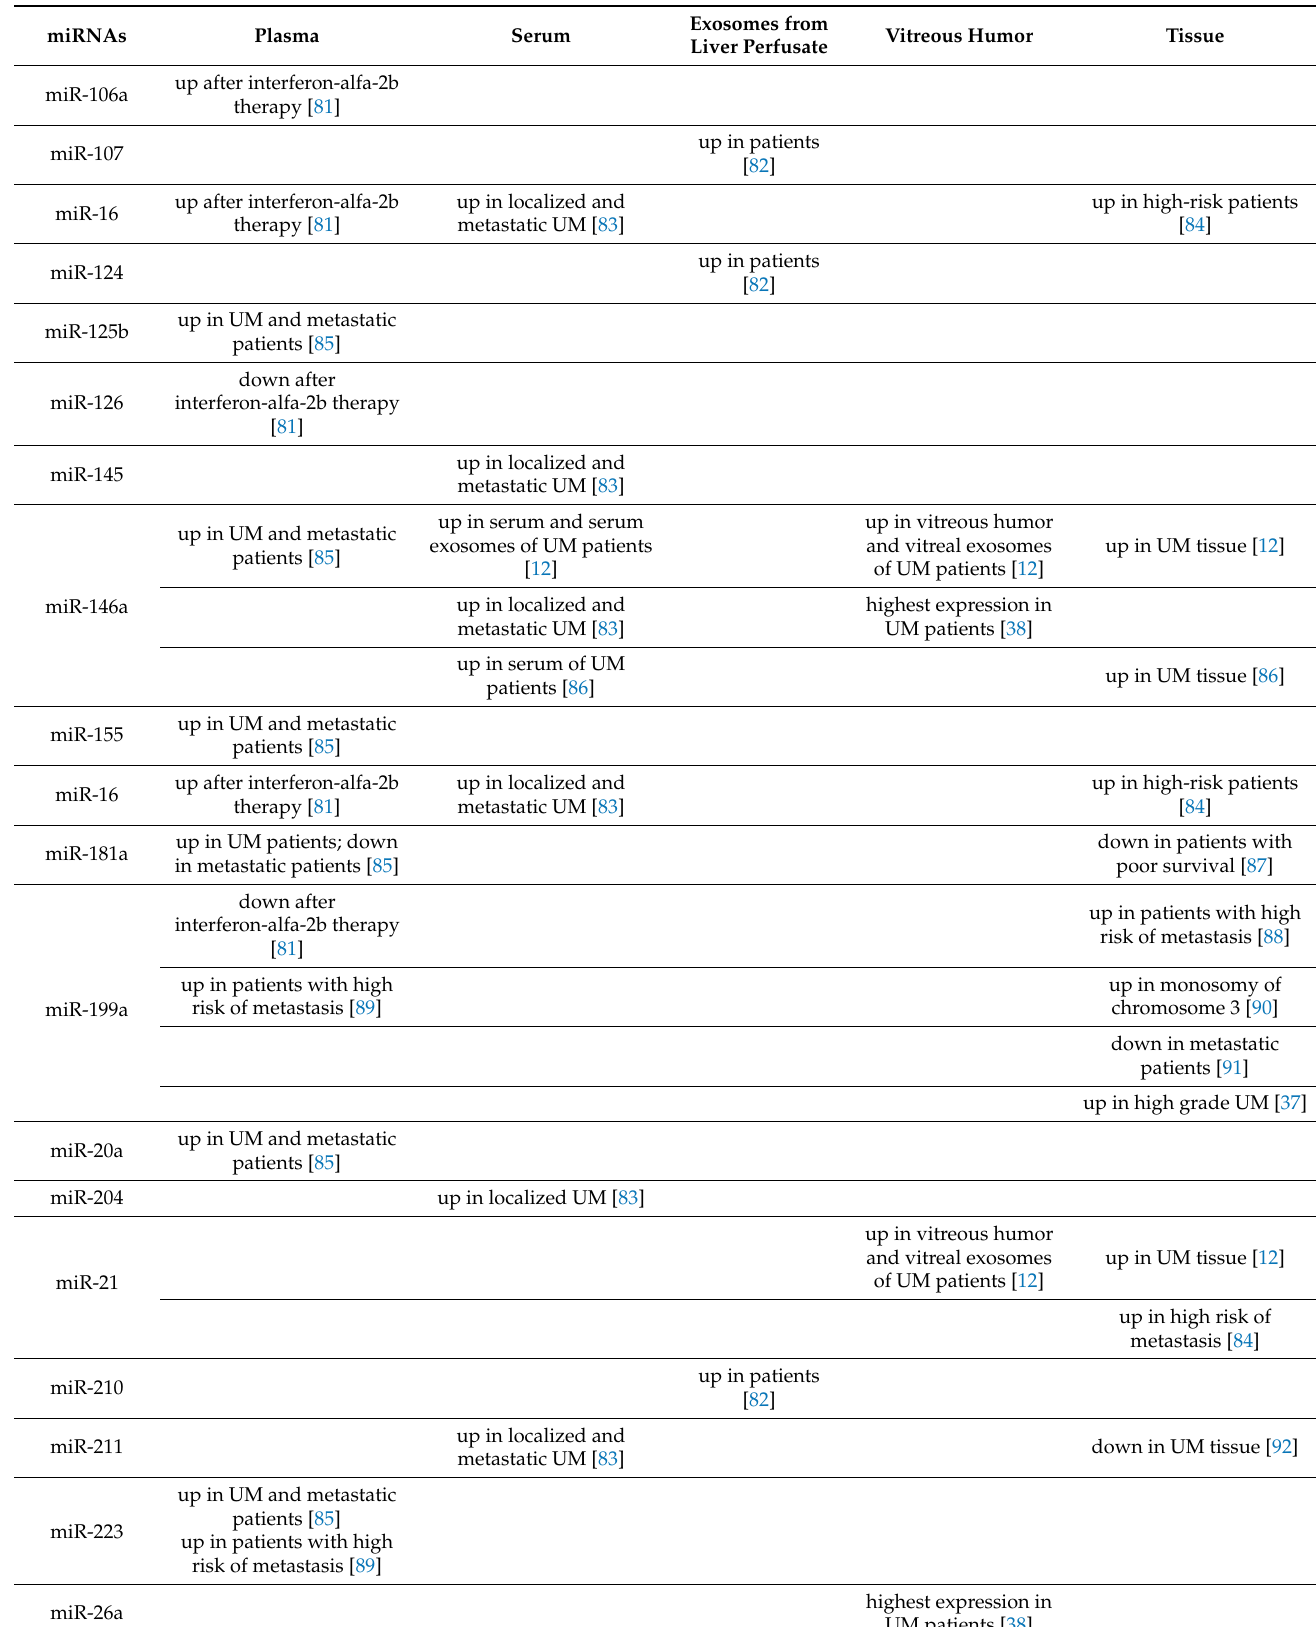
Table 1. miRNAs showing altered expression in extracellular compartments and tissues in UM